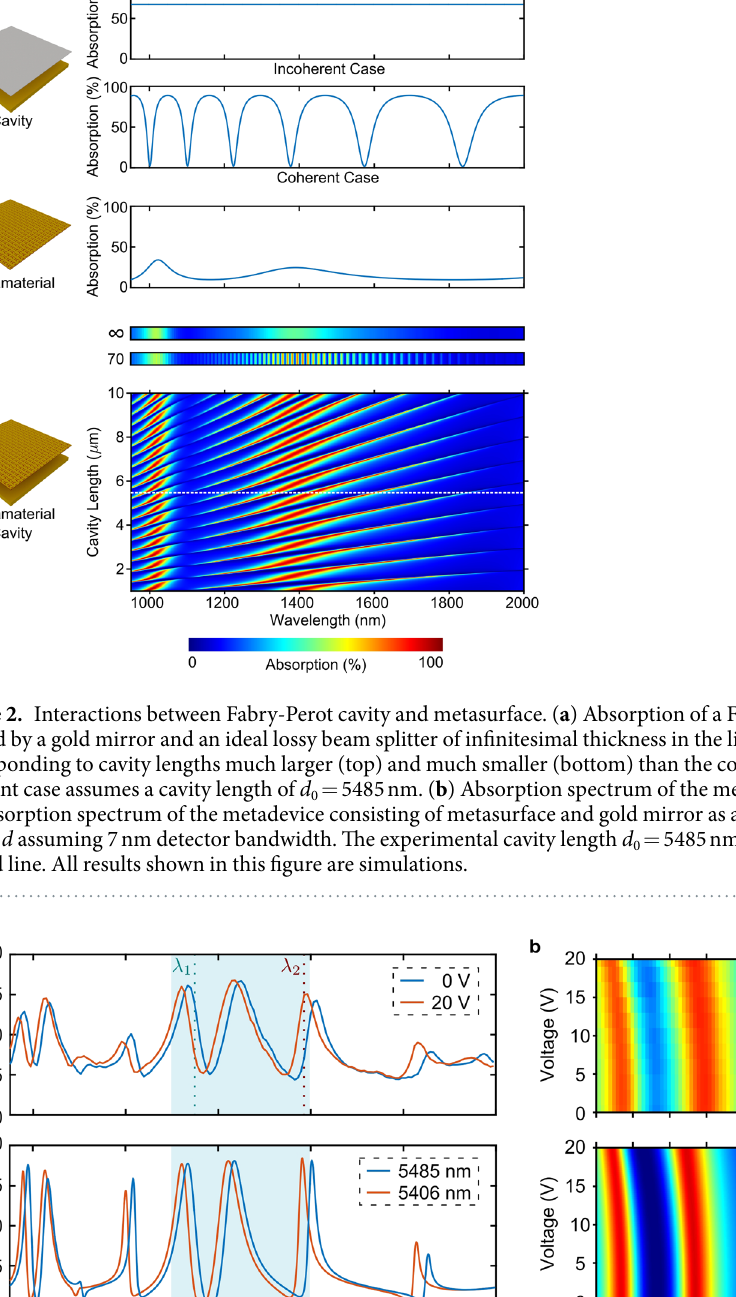
magnitude, i.e. a 20 nm blue-shift around 1400 nm wavelength. The measured and simulated voltage-dependence of absorption is given by Fig. 3b for the spectral range of highest contrast and the corresponding metasurface displacements that were determined by fitting the experimental absorption spectra are shown by Fig. 4a. Both